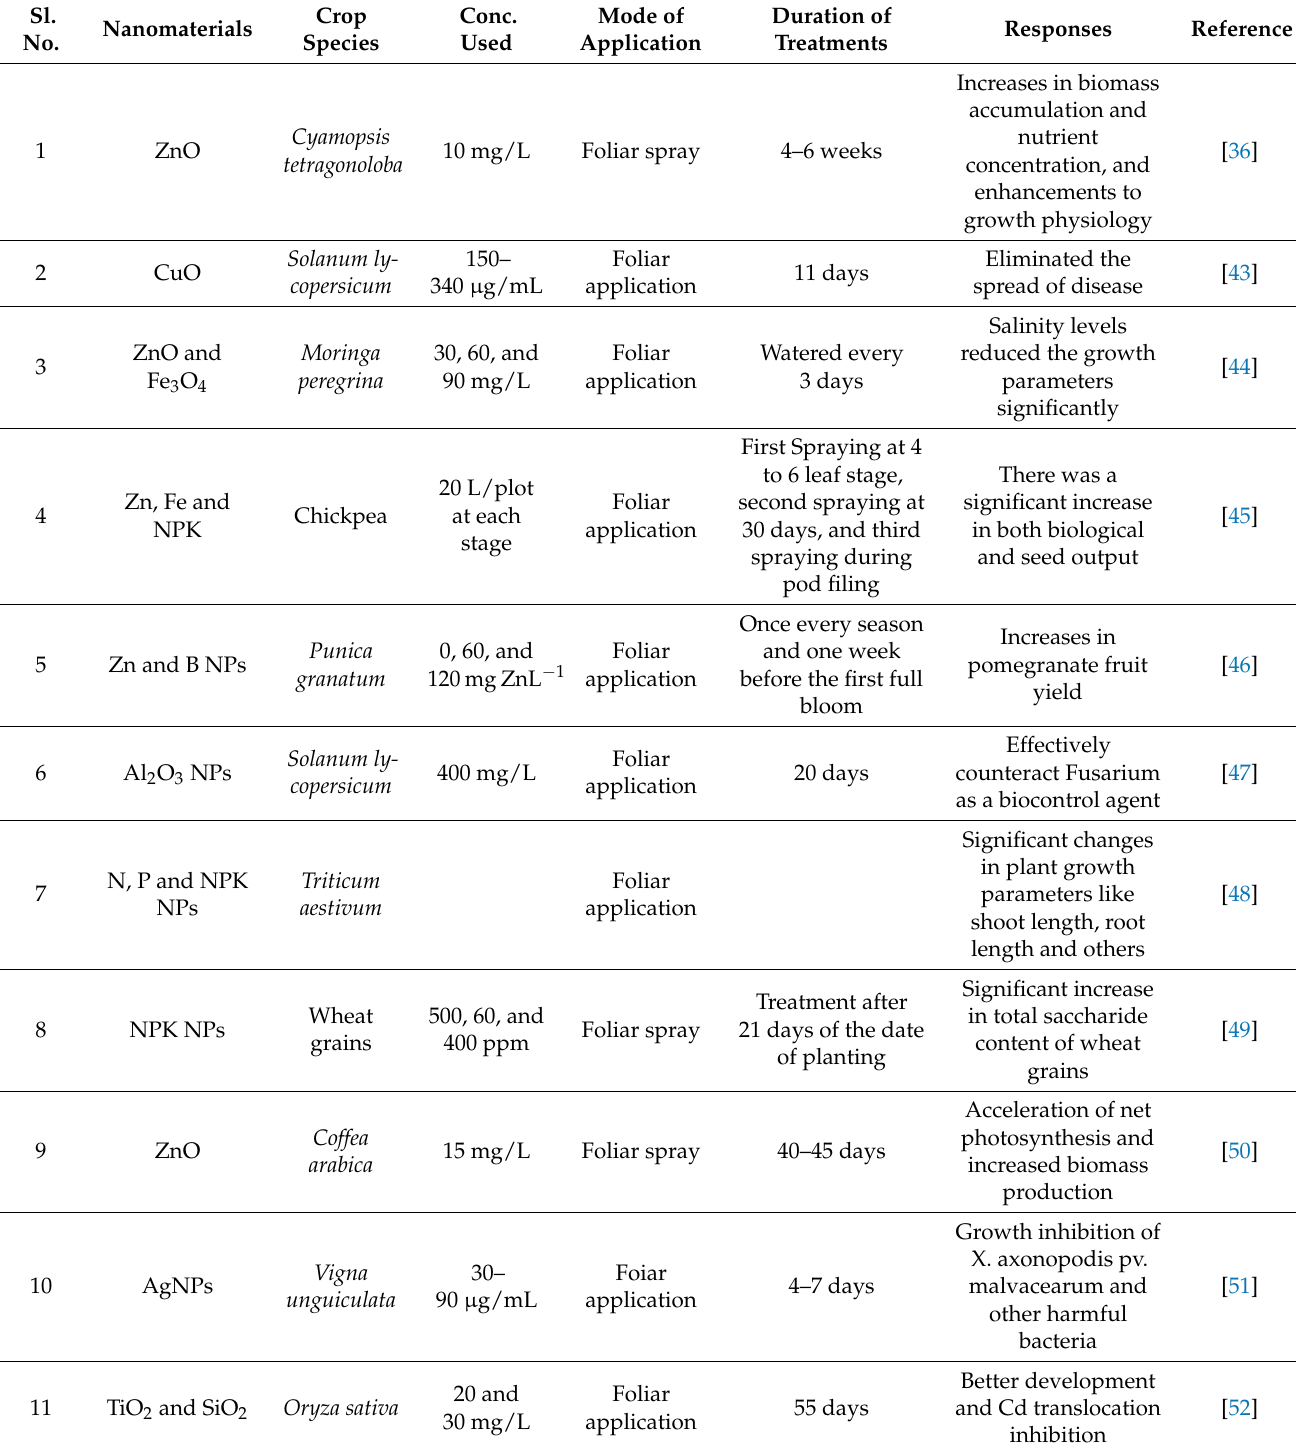
Table 1. Effects of foliar application of nanofertilizers in different crops and plants.